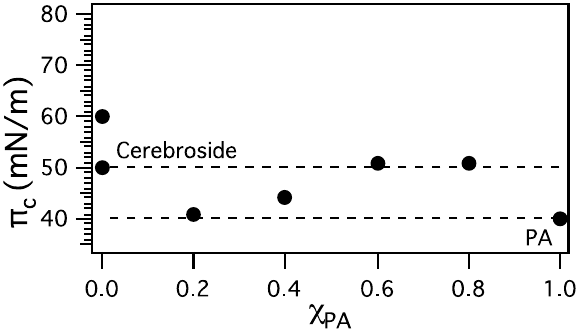
Figure 5. Collapse pressures of mixed PA/cerebrosides monolayers as a function of PA chemical